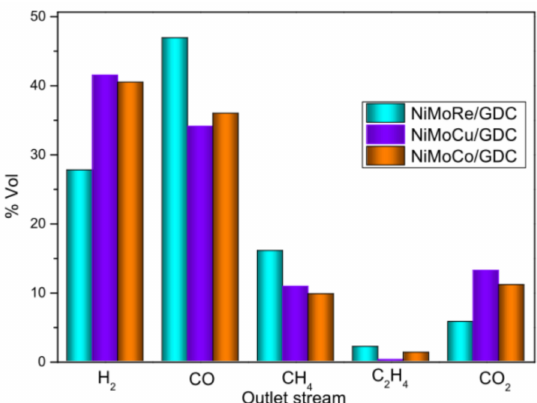
Figure 7. Comparison of products distribution of ATR reaction catalyzed by different catalysts, after 10 h, 120,000 h − 1 space velocity, and 600 ◦